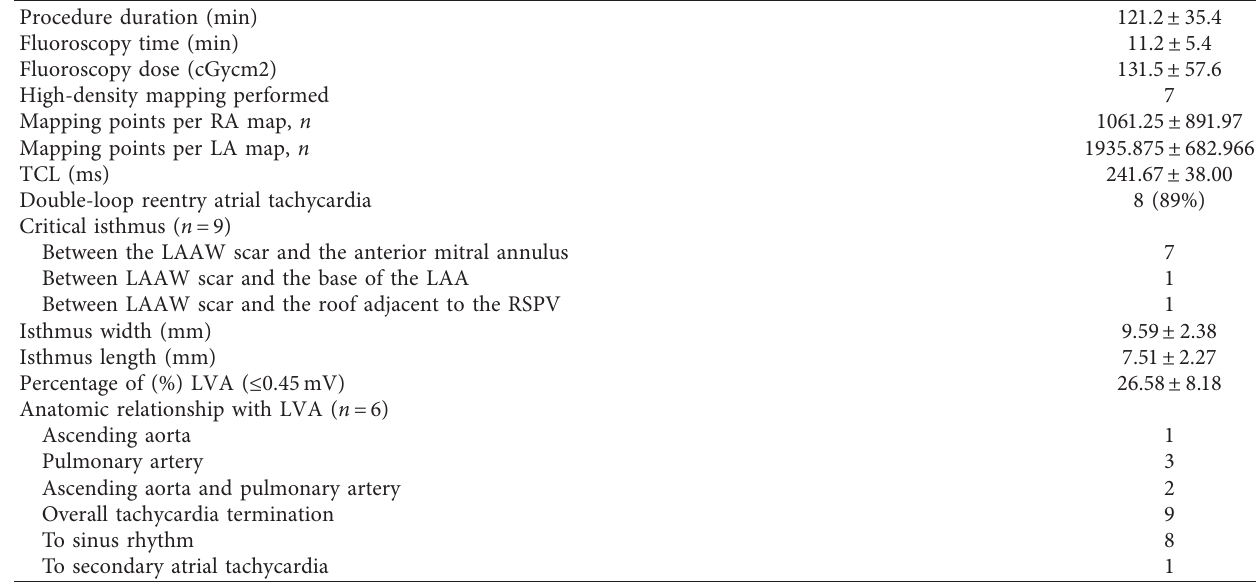
Table 2: Mapping and ablation characteristics of